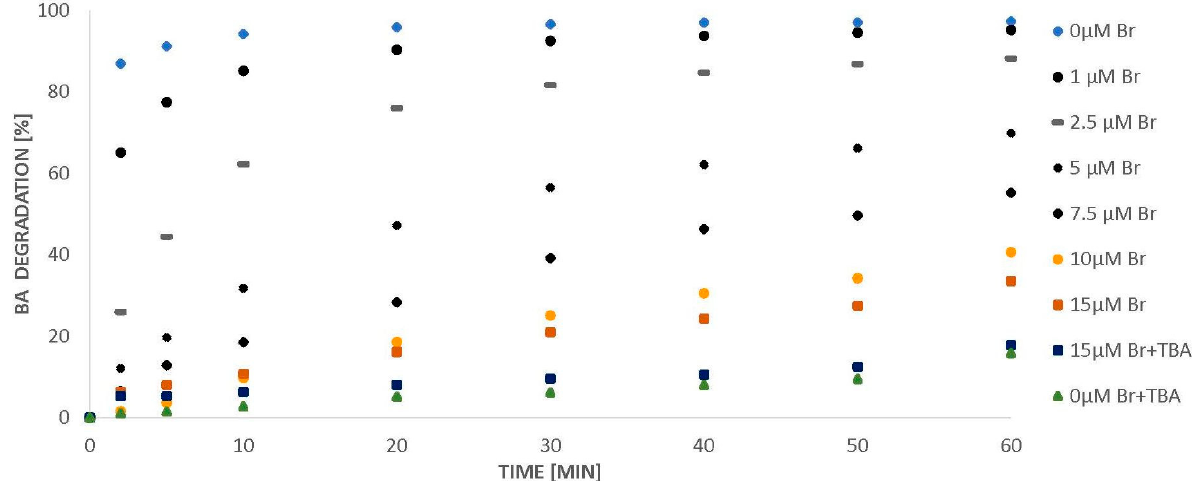
Figure 3. Degradation of BA (24 µM) in the presence of bromides (0–15 µM), pH = 2.5. At the same time, with the increasing amount of bromides, a decrease in the BA deg- radation reaction rate constant was observed (Figure 4).